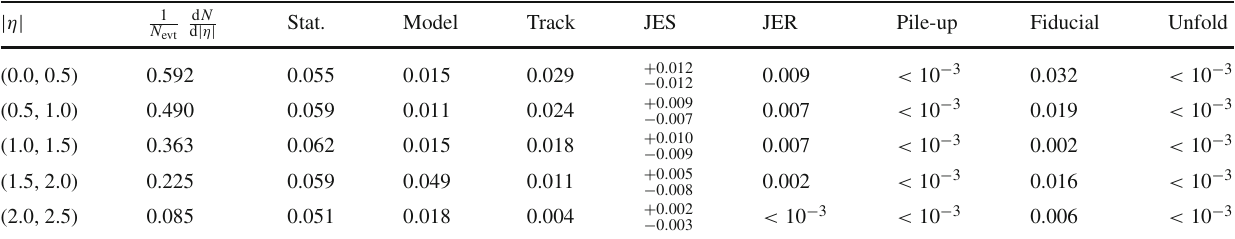
associated with b -jets, and including invisible decays, along with the S